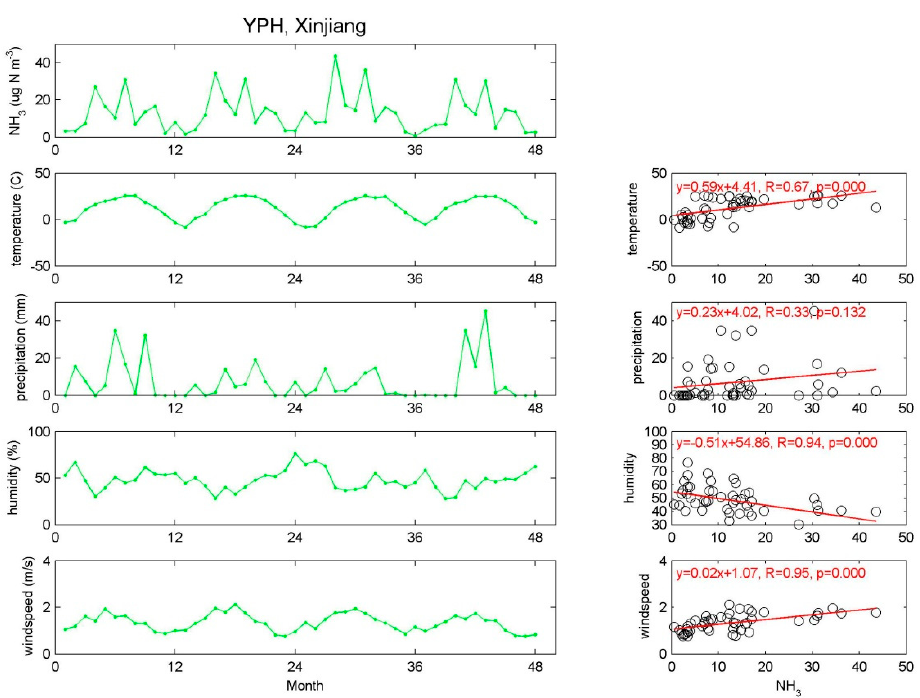
Figure A7. The seasonal variations of ground NH 3 concentrations (µg N m − 3 ), temperature (°C), precipitation (mm), humidity (%), and wind speed (m/s) at YPH from January 2010 to December 2013 (0–12, 2010; 13–24, 2011; 25–36, 2012; 37–48, 2013).